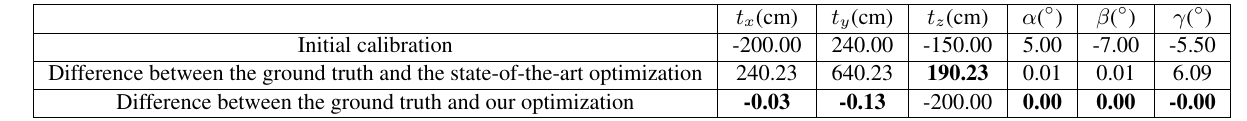
Table 5: Optimization of the calibration of synthetic point cloud #2